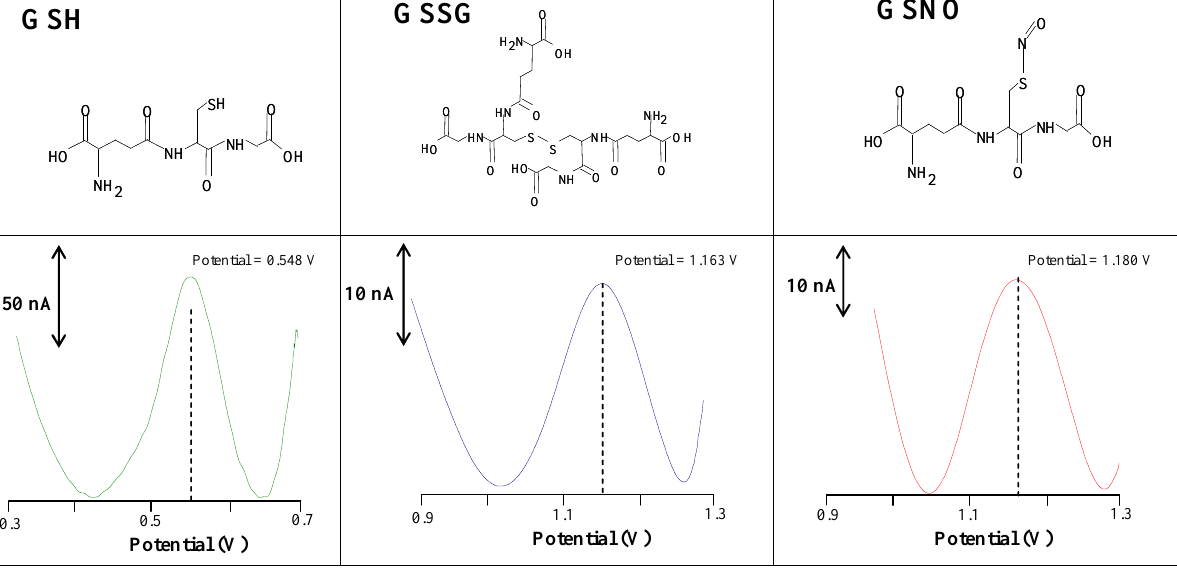
Figure 1. Chemical structures of reduced (GSH), oxidized (GSSG) and S-nitroso (GSNO) glutathiones. Square wave voltammograms of GSH, GSSG and GSNO measured on carbon paste electrode using AUTOLAB Analyser. The supporting electrolyte: Britton-Robinson buffer, pH 5. SWV parameters were as follows: the initial potential of –0.2 V, the end potential 1.5 V, frequency 200 Hz and step potential 5 mV. The concentration of thiols was 100